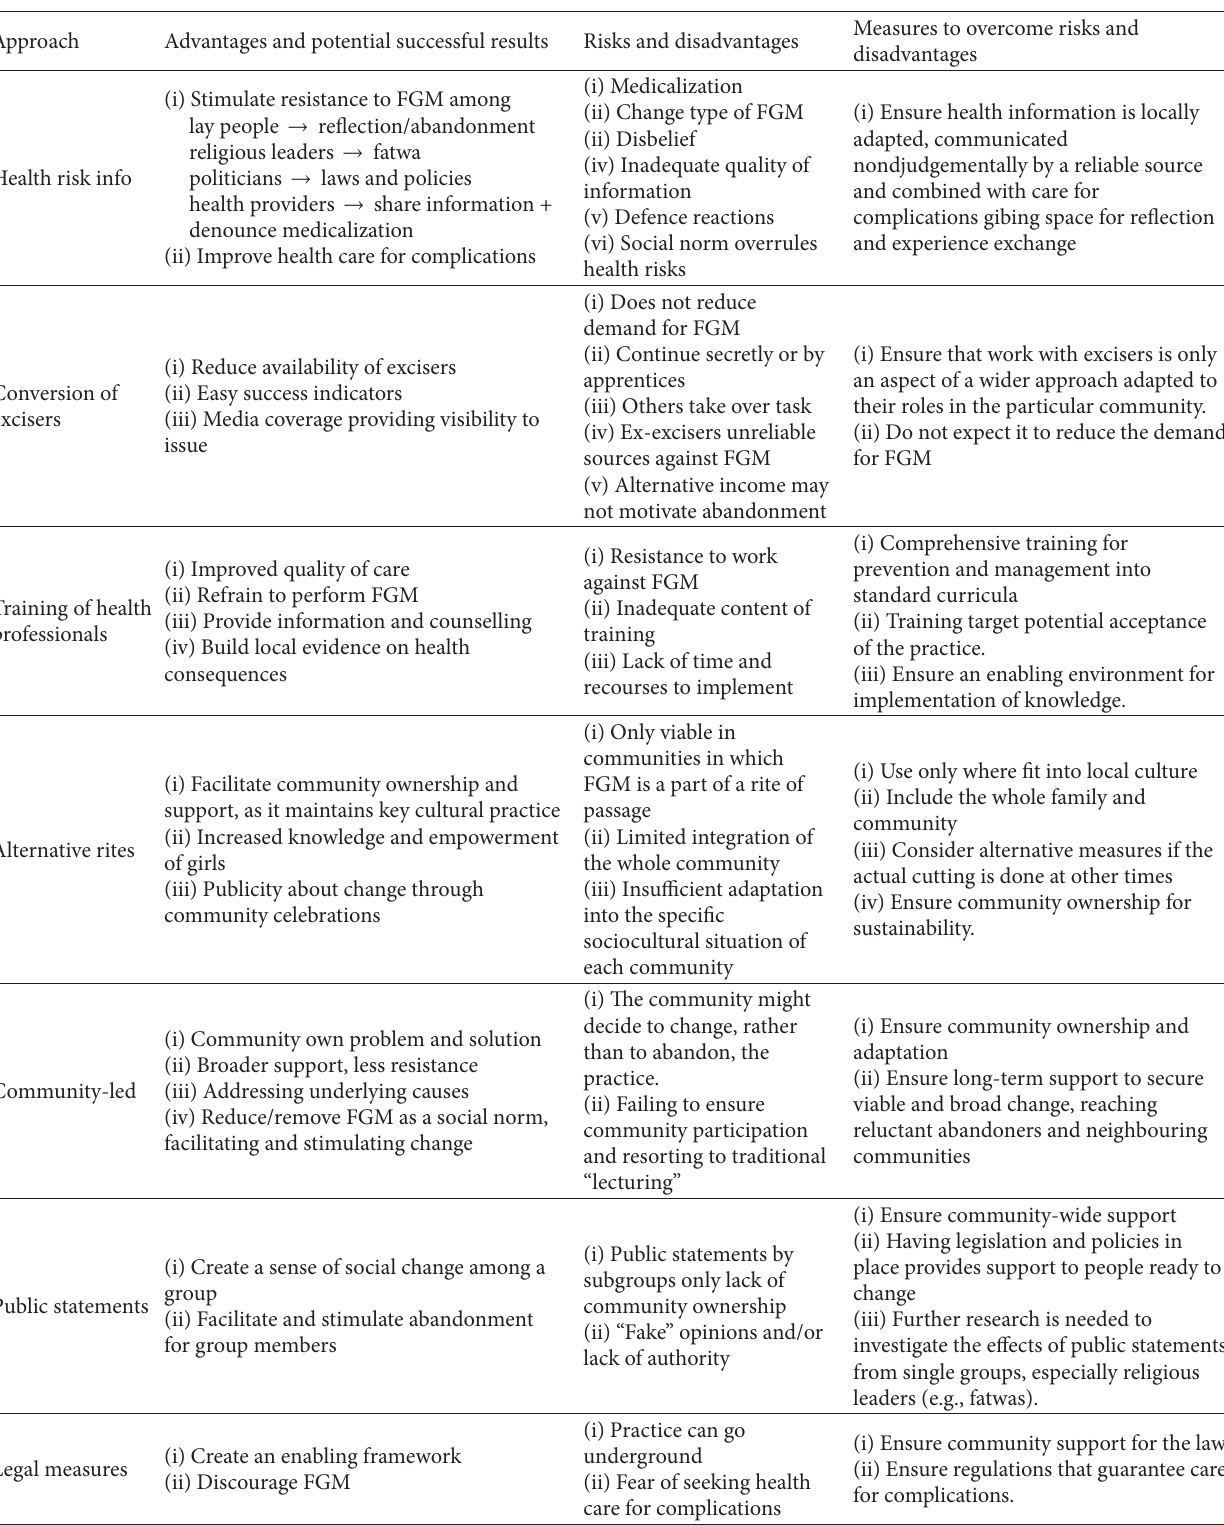
Table 1: A summary of the main advantages and challenges of popular approaches towards the abandonment of FGM.